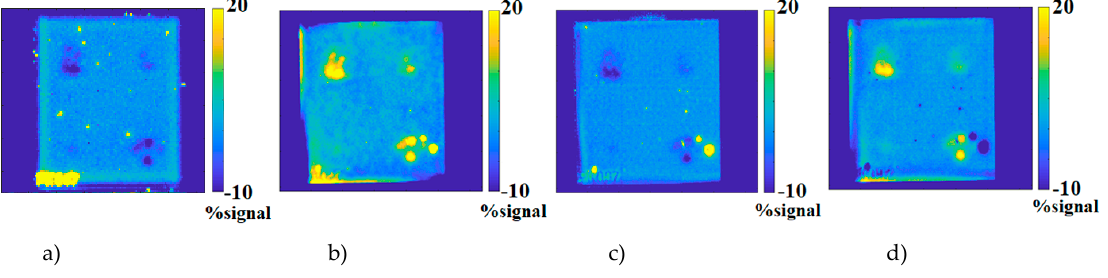
Figure 4. ( a ) 2 nd derivative best maps (frame 132 of 512), TSR, pulsed thermography, ( b ) slope by analyzing the cooling trend with a linear fitting, frame by frame (frame 328), stepped thermography ( c ) R 2 by analyzing the cooling trend with a linear fitting, frame by frame (frame 75), stepped thermography, ( d ) 2 nd derivative best maps (frame 27 of 512), TSR, stepped